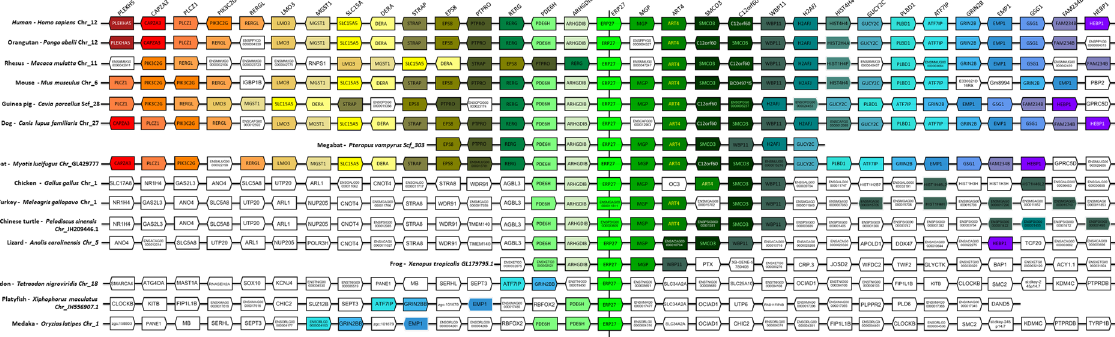
Figure 5. Alignment of the genomic region containing PDIA8/RhoGDI β cluster in vertebrates. Gene names and positioning are based upon the Genomicus database (see methods). All species are aligned against Homo sapiens . The map is centralized in PDIA8 (Erp27)/RhoGDI β (ARHGDIB) gene pair. Genes are aligned in columms and kept in the order in which they appear in chromosomes (Chr) and scaffolds (Scf), without consideration for distance, while the transcriptional sense is represented by the pentagon tip. All orthologs are drawn with the same color and the lettering on the top refers to the Homo sapiens genes. In addition to the main genes of interest, the neighboring genes are included for